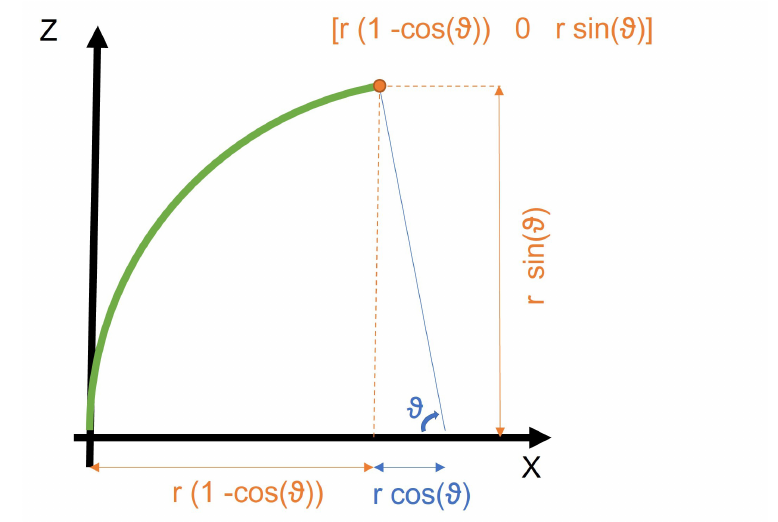
Figure 9. Deduction of translation movement for the